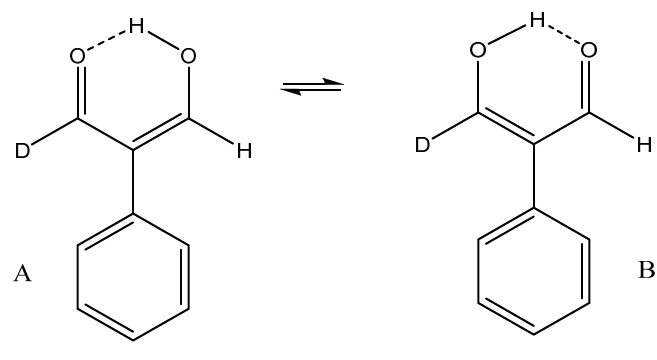
Figure 14. Isotopic perturbation of equilibrium.